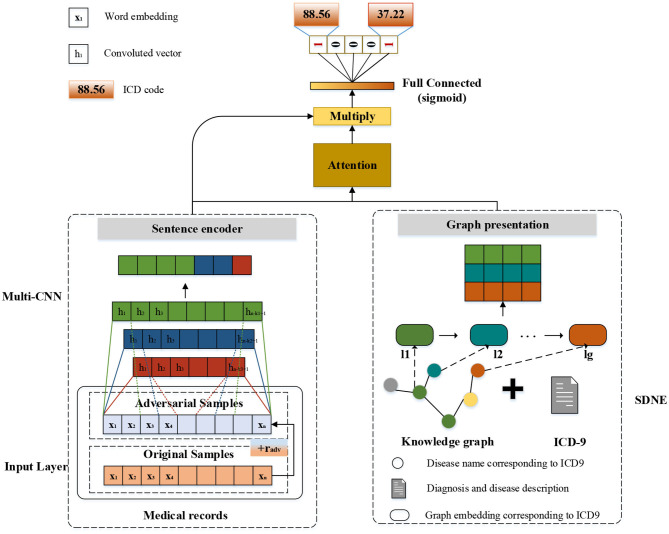
The overview of G_Coder.